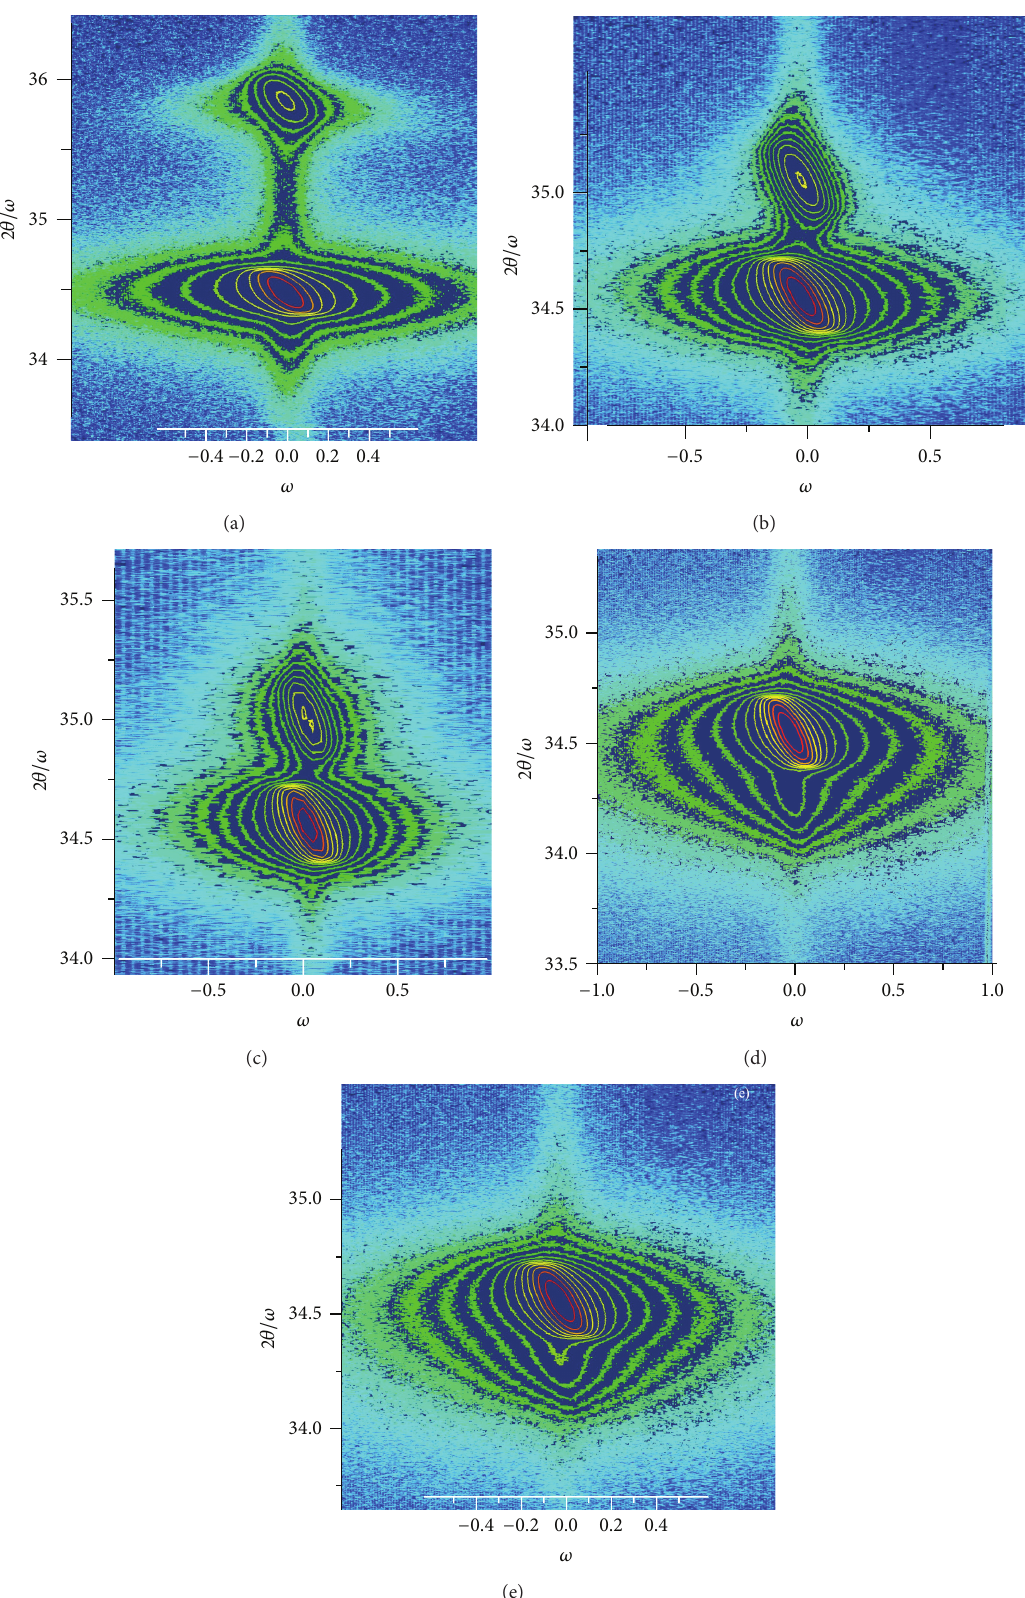
Figure 5: HR-XRD reciprocal space-maps of the (0002) reflection for AlInN/GaN/Al 2 O 3 structures with different indium content. In content changes as (a) 4%, (b) 18%, (c) 20%, (d) 47%, and (e)